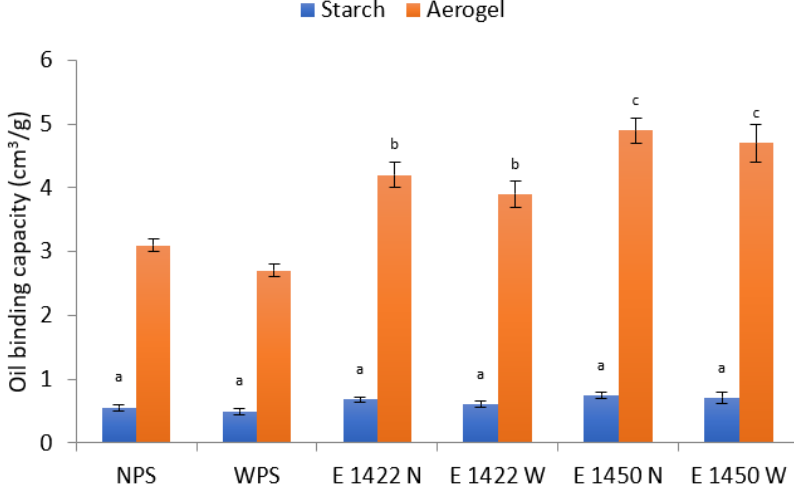
Figure 3. Oil-binding capacity of aerogels and the corresponding starch raw materials. Mean value ± standard deviation. Samples denoted with the same letter do not differ significantly p > 0.05.